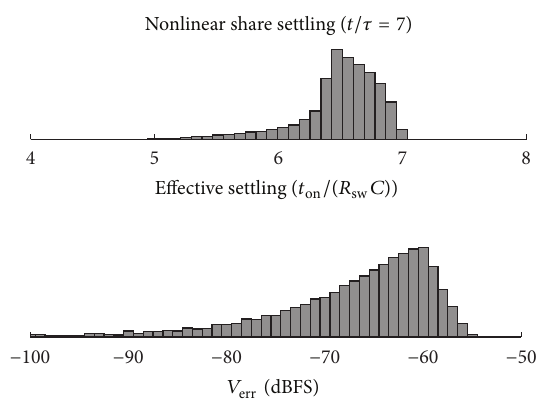
Figure 18: Monte Carlo simulations of the settling error in a 2-point share operation with voltage dependent switch resistance.